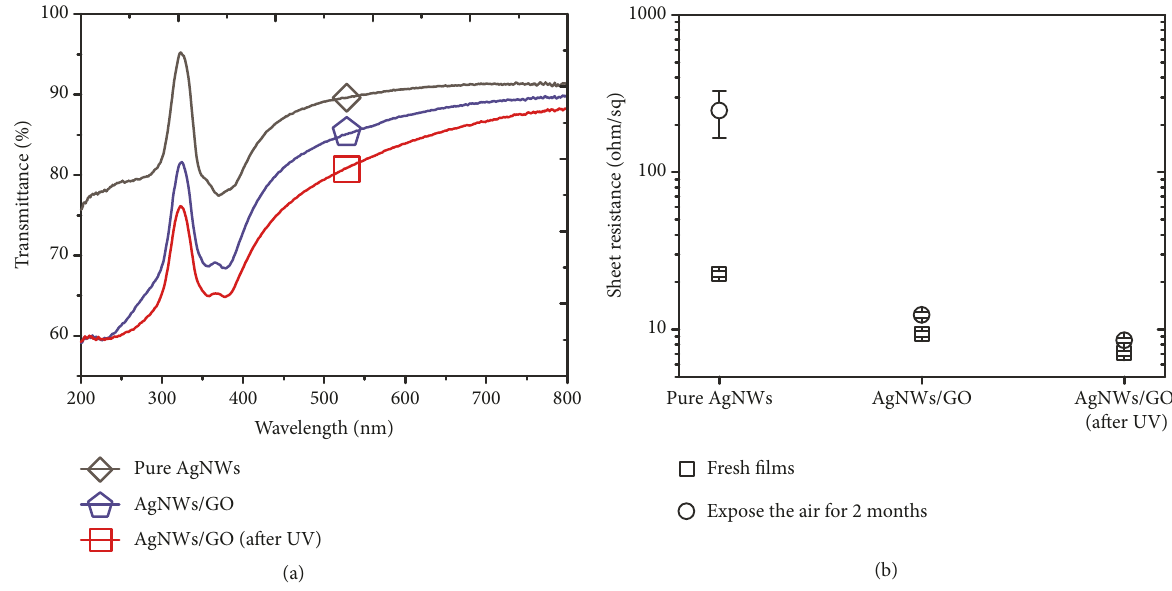
Figure 7: (a) Optical transmittance spectra of the pure Ag NW networks and the Ag NWs/GO composite film before and after UV light- induced treatment. (b) Environmental stability test of pure Ag NW networks and composite films.